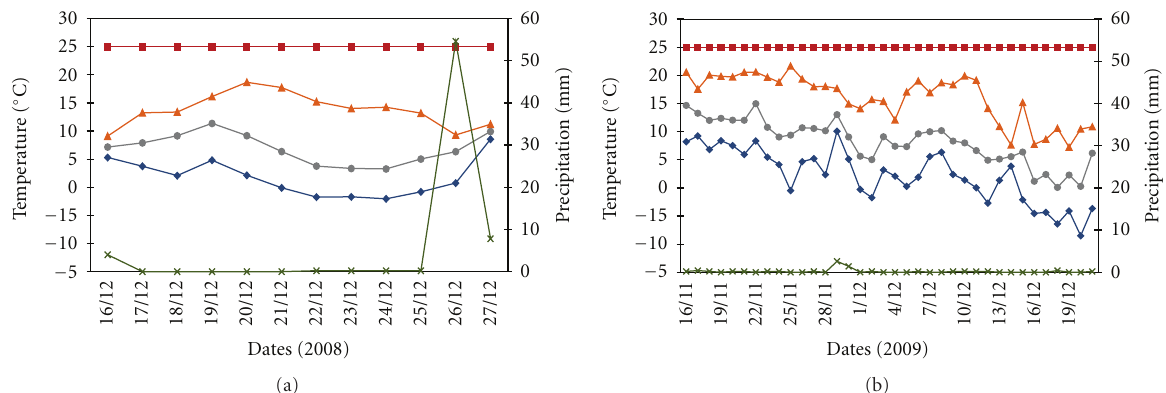
Figure 2: Temperature and rainfall recorded within the observation plot and temperature in the control under chamber conditions (line with squares for temperature in the control; line with triangles for daily maximum temperature; line with circles for daily average temperature; line with rhombus for daily minimum temperature; dotted line for